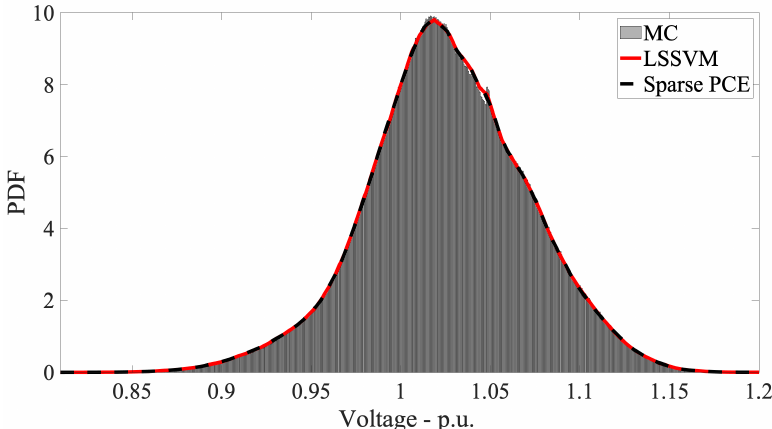
Figure 10. PDF of the per-unit (p.u.) magnitude of the nodal voltages calculated for Case 1 from the MC samples and with the compressed LS-SVM and sparse PCE surrogate models.